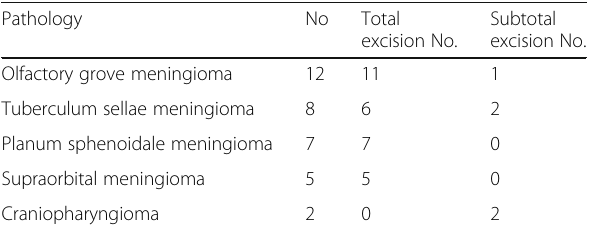
Table 2 Relation between tumor type and degree of surgical excision Pathology